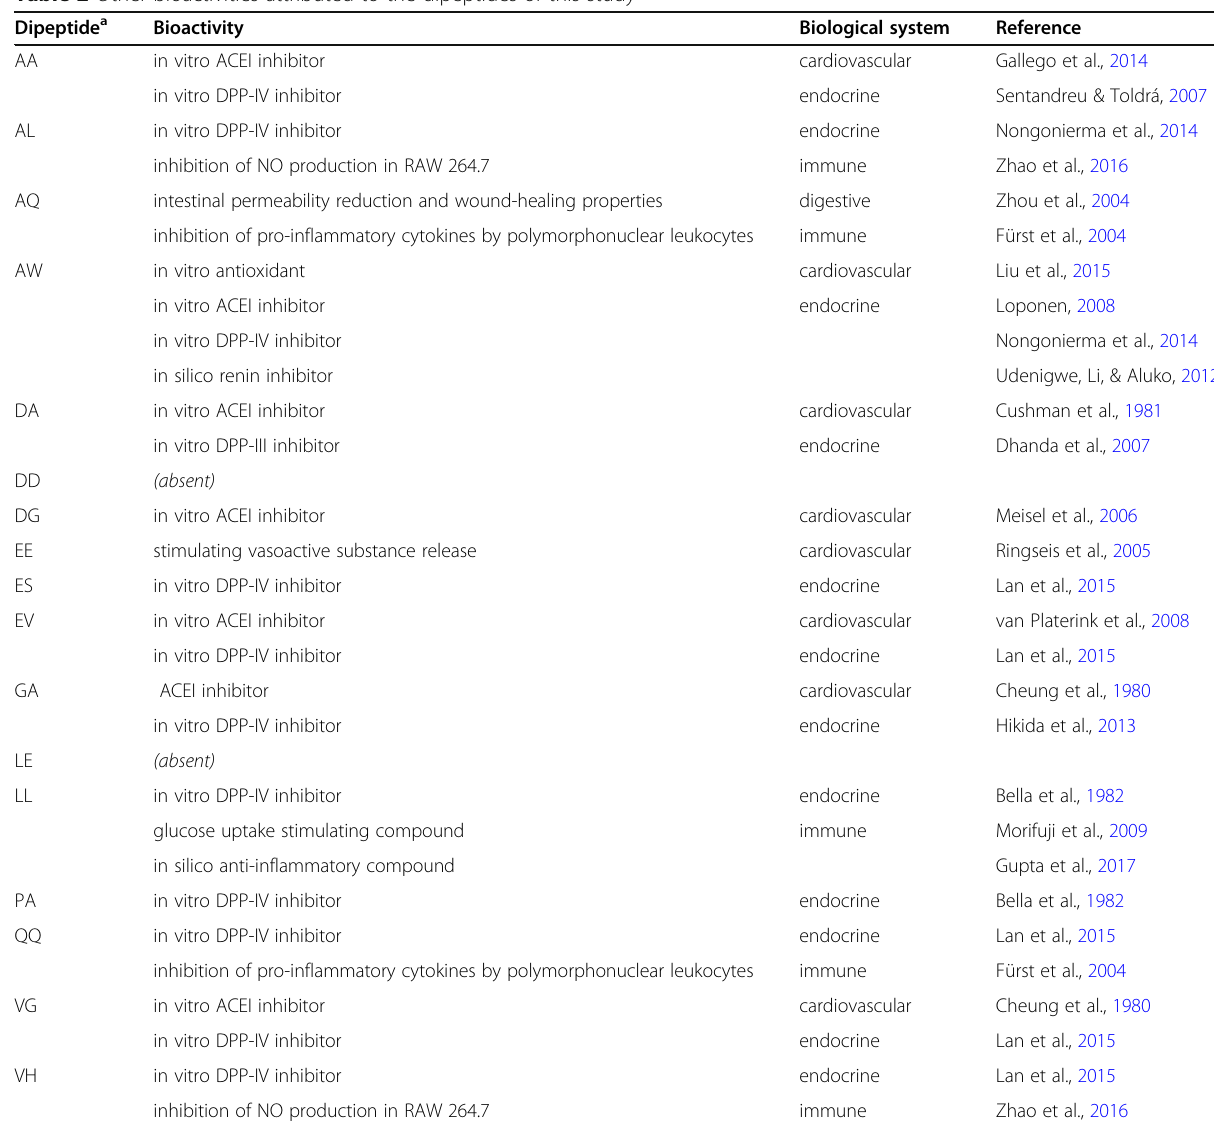
Table 2 Other bioactivities attributed to the dipeptides of this study Dipeptide